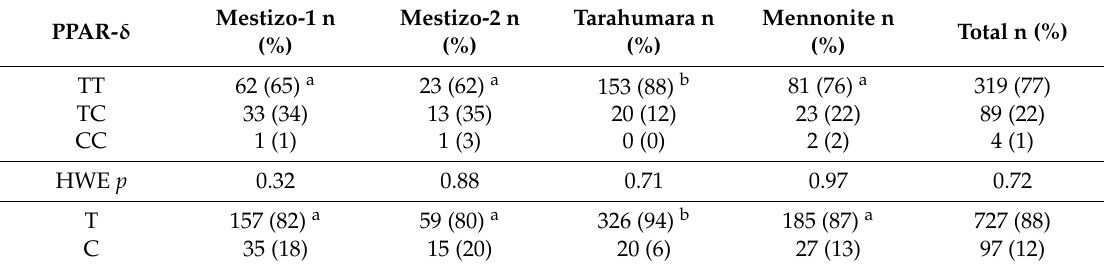
Table 4. + 294T / C PPAR- δ genotype and allelic frequencies comparison among populations. PPAR-